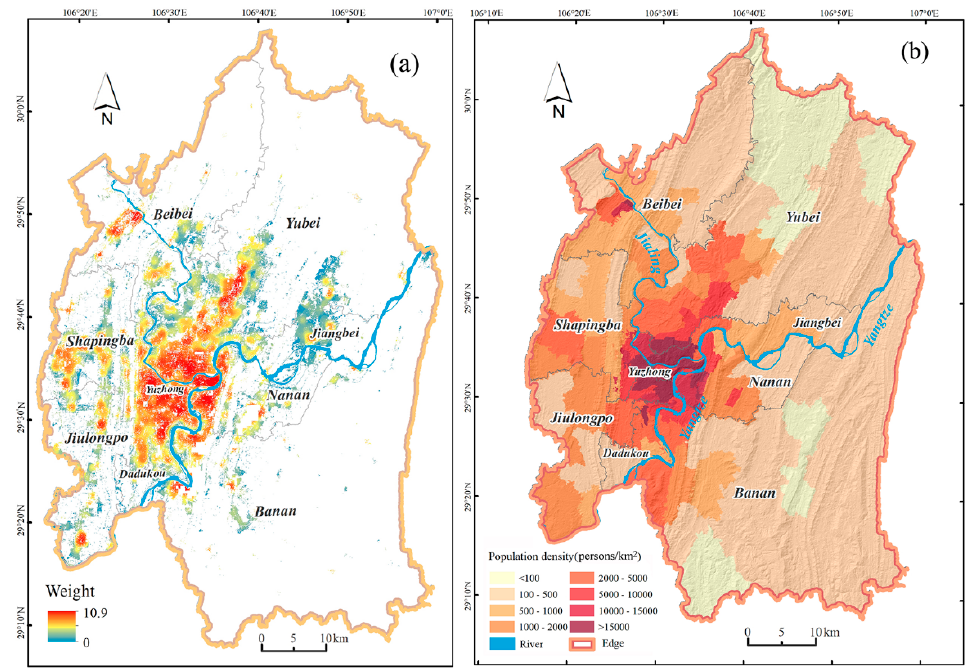
Figure 5. ( a ) Distribution weights of the population at a 30 m spatial resolution and ( b ) census population at the subdistrict level in central Chongqing.